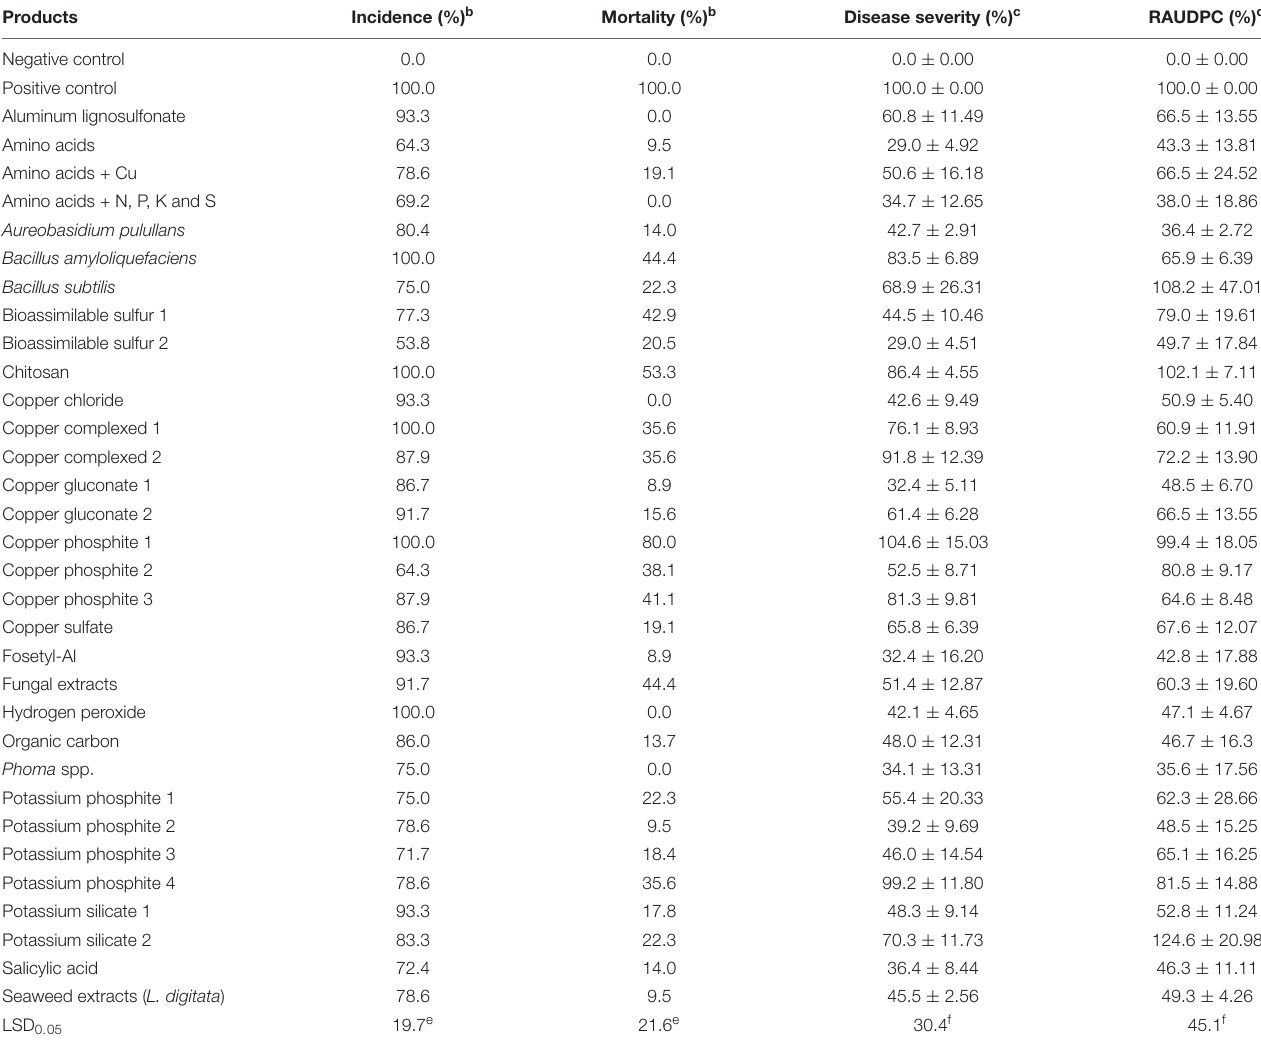
TABLE 4 | Disease-related parameters for olive plants grown in artificially infested substrate with the defoliating Verticillium dahliae isolate V180 and treated with the evaluated products by foliar application a